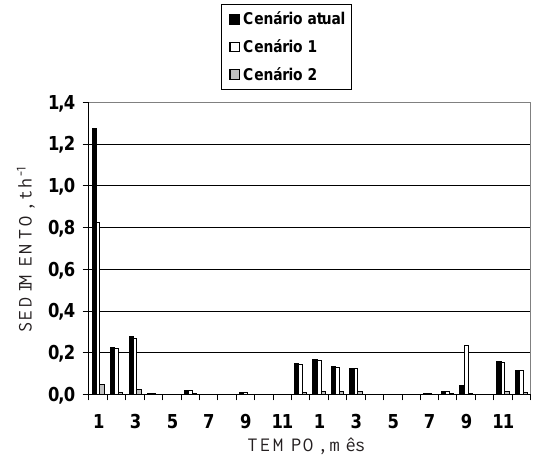
Figura 3. Comparação da variação temporal da produção de sedimentos entre os três cenários no posto hidrossedimentométrico localizado na